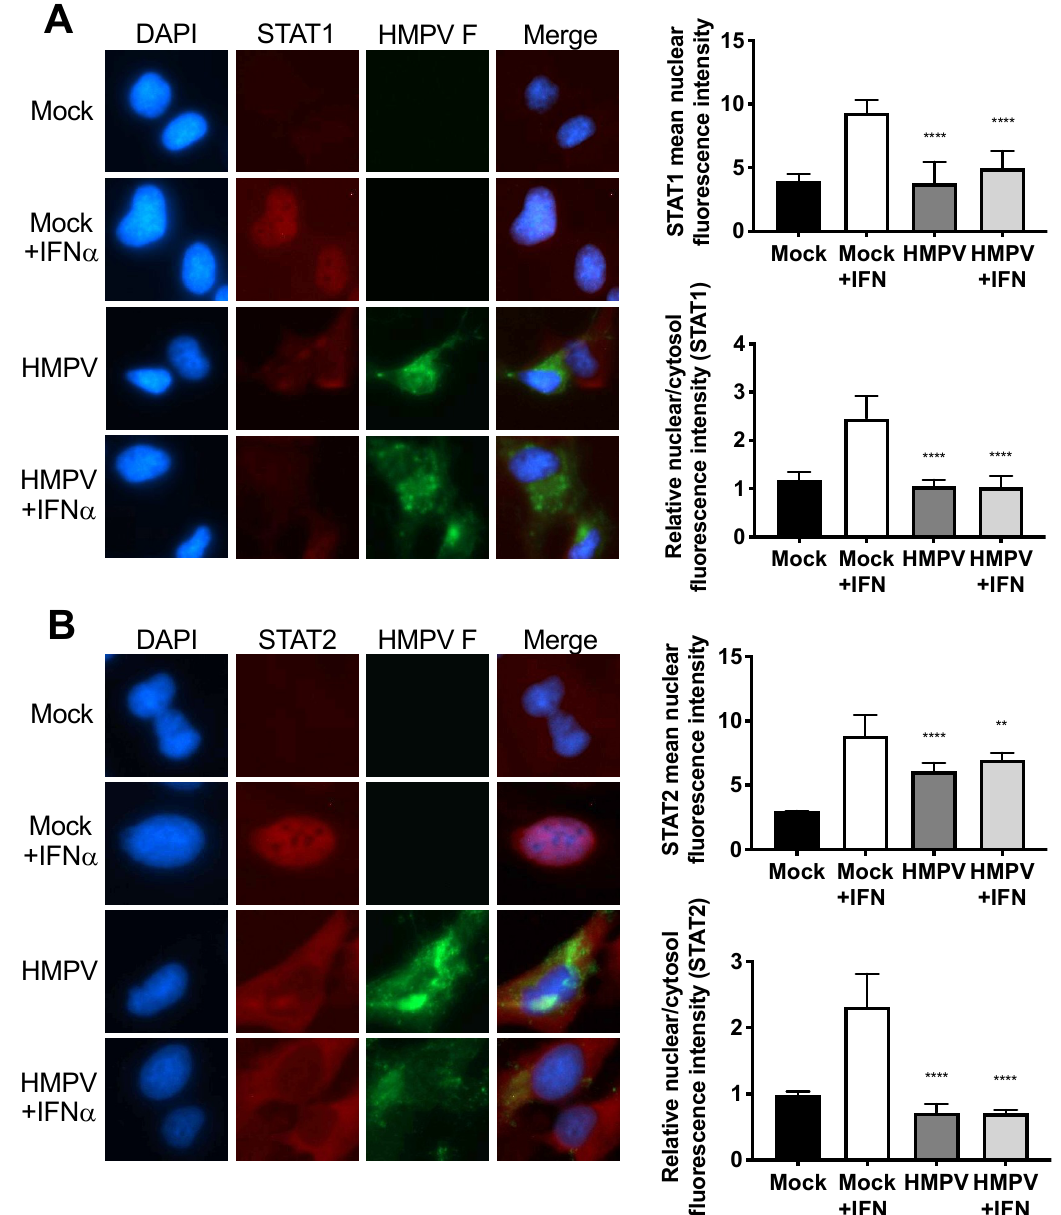
Figure 2. Nuclear localization of STAT1 and STAT2 is inhibited by HMPV. Human BEAS2b cells were infected with HMPV or mock for 20 h, and treated with IFN for 40 min. After IFN treatment, cells were fixed, stained for immunofluorescence, and images were captured at 40 × magnification. The fluorescent intensities of the nuclear and cytosolic STAT1 or STAT2 fluorescence signals was quantified. ( A ) HMPV infection inhibits nuclear translocation of STAT1. ( B ) STAT2 nuclear localization is impaired during HMPV infection. Note reduction of STAT1 / 2 (red) signal in nuclei of HMPV-infected (green) cells. ** p < 0.01, **** p < 0.0001 compared to Mock + IFN, one-way ANOVA with Tukey post-hoc test. Images are representative of 2 independent experiments. Data in graphs are from two experiments.